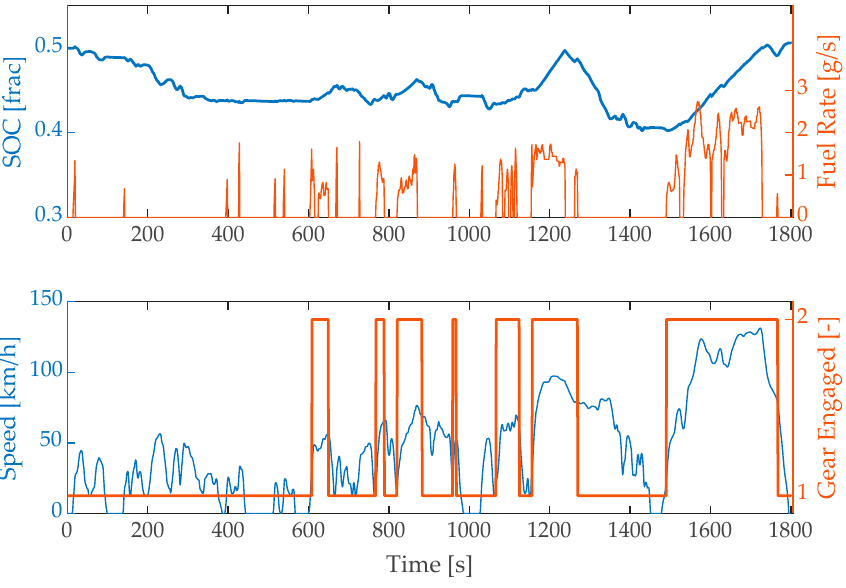
Figure 6. Example of the DP control results for a two-speed HEV driving the worldwide harmonised light vehicles test procedure (WLTP), equipped with a 68 kW ICE and a 14 kW EM.